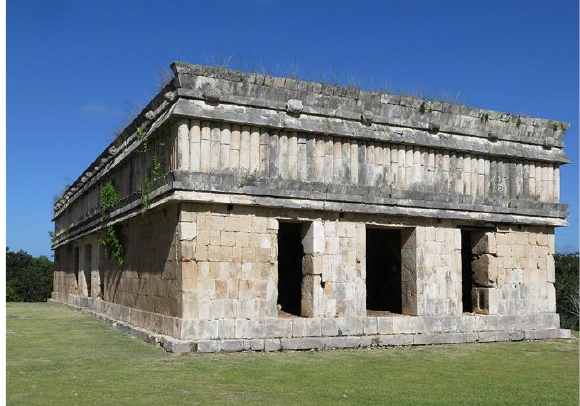
Figure 6. House of the Turtles of Uxmal.